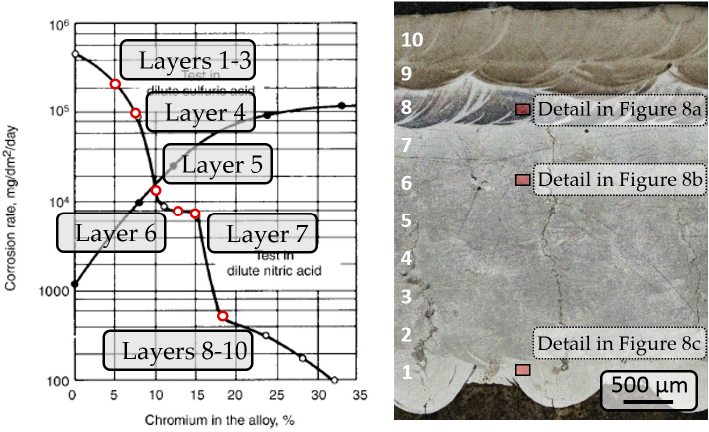
Figure 6. Corrosion resistance of each layer as a function of chromium content of the alloy.